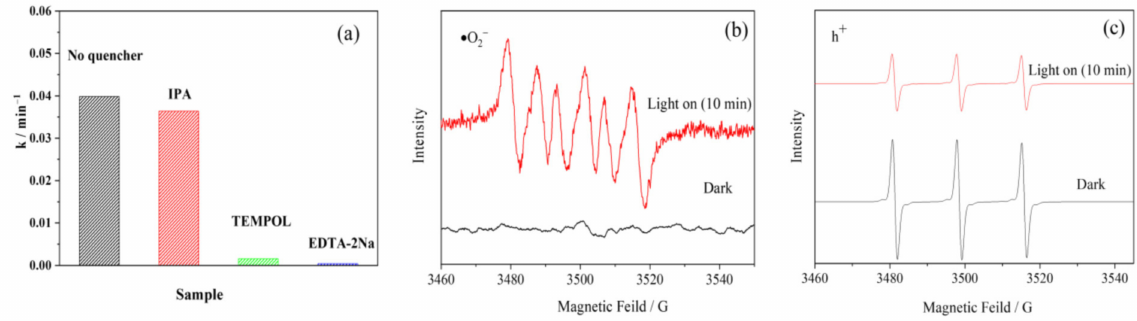
Figure 8. ( a ) Effects of active species scavengers on the degradation of MB for 3:1-Ag/CNH(III); ESR spectra of 3:1-Ag/CNH(III) for detecting ( b ) DMPO- · O 2 − and ( c ) TEMPO-h + .